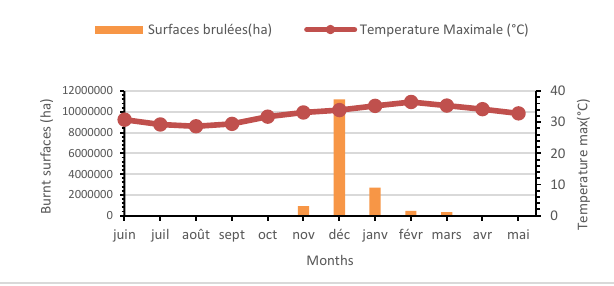
Figure 14: Interrelation between maximum temperature and burnt surfaces